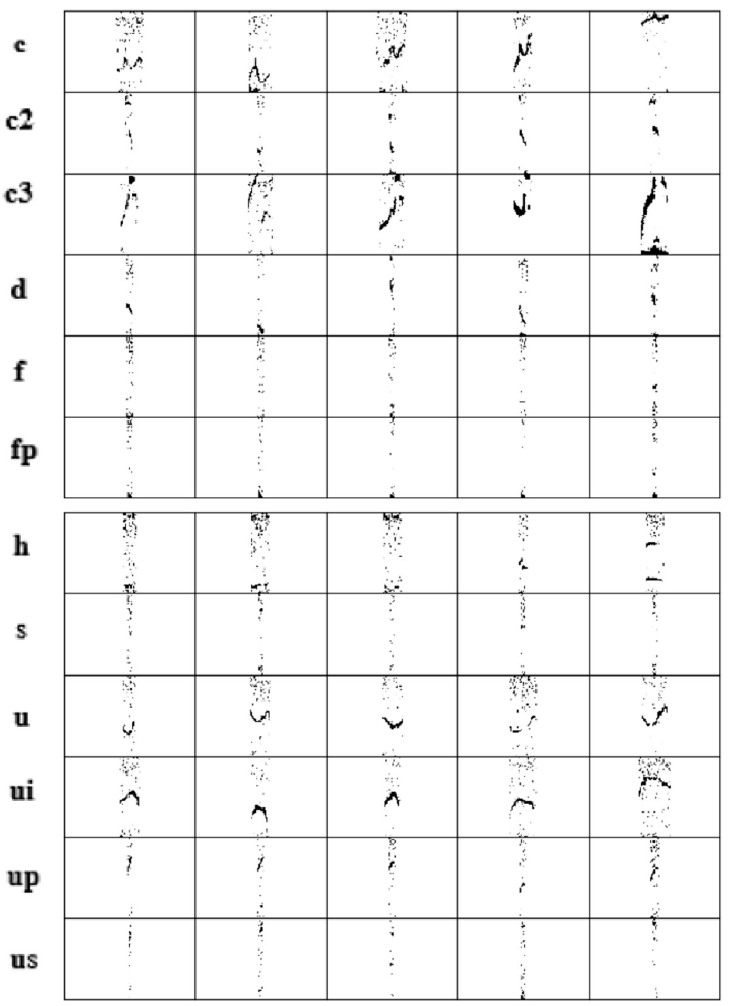
Fig 2. Gammatone Spectrograms (GSs) of five members of 12 studied classes. These GSs have the minimum Manhattan distance to other members of 12 USV classes in the development